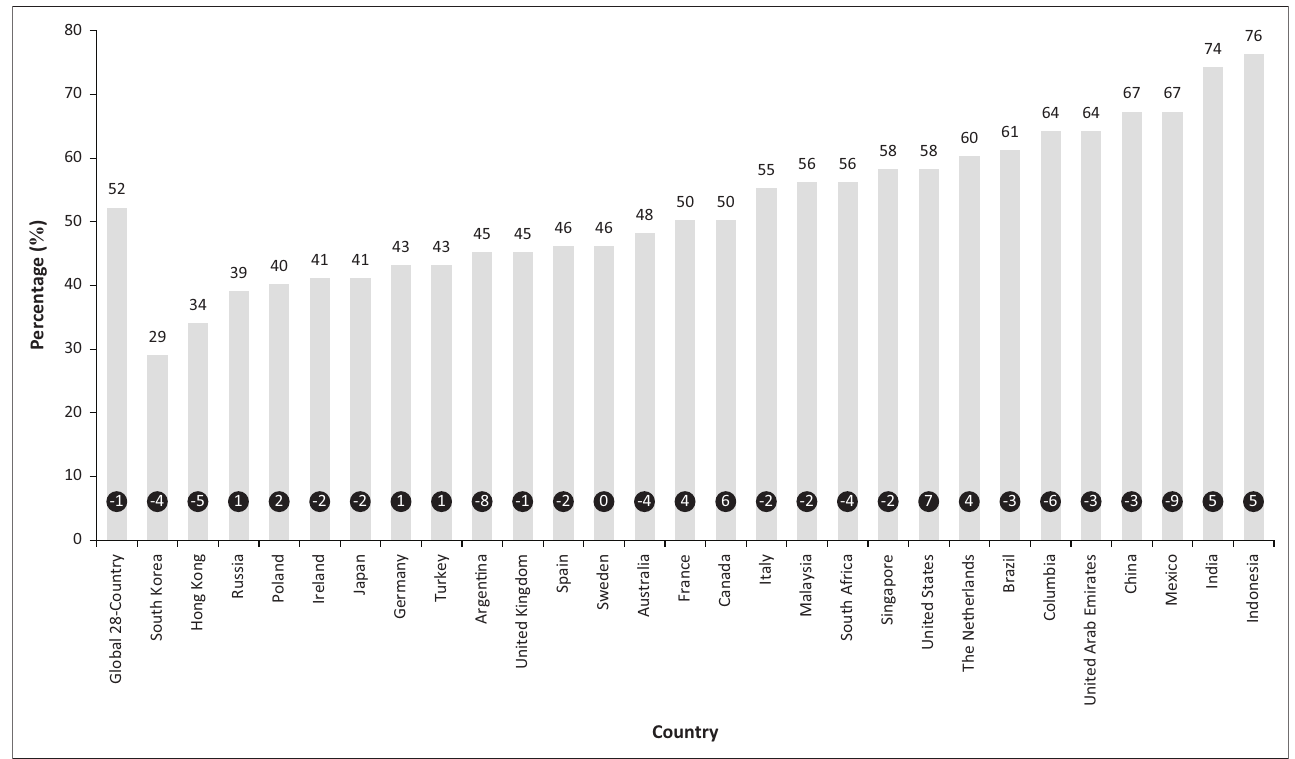
FIGURE 1: Trust in private businesses: A global